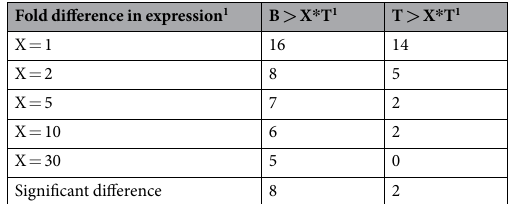
Table 3. Difference in expression between B cells and T cells for 30 of the top 40 expressed genes from the random forest prediction. 1 X is the fold difference in expression between the two cell